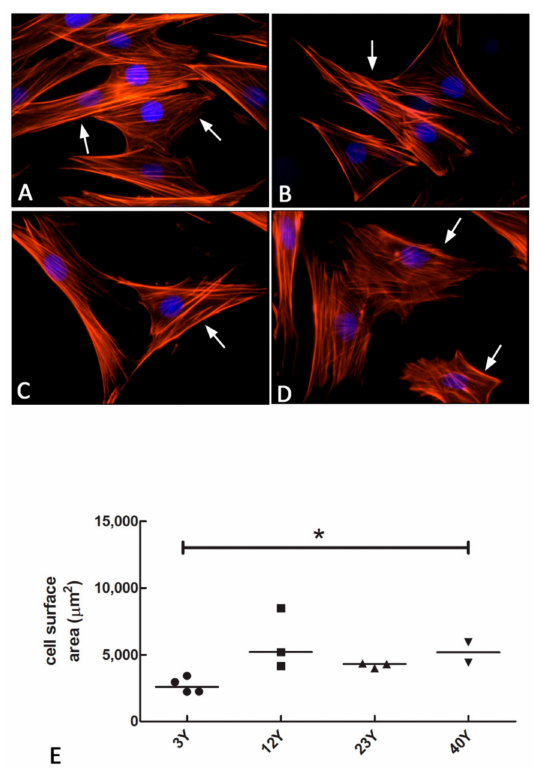
Figure 6. Fluorescence microscopy images of the phalloidin staining assay demonstrating the presence and distribution of actin fibers (red color; arrows) in equine SfMSCs isolated from donors of di ff erent ages. Nuclei were counterstained with DAPI (blue color). All the images have a magnification of 600 × and are representative of three independent experiments. ( A ) SfMSCs isolated from equine donors of 3 years of age; ( B ) SfMSCs isolated from equine donors of 12 years of age; ( C ) SfMSCs isolated from equine donors of 23 years of age; ( D ) SfMSCs isolated from equine donors of 40 years of age. ( E ) Quantitative analysis of the cell surface area of equine SfMSCs isolated from donors at di ff erent ages and stained with phalloidin probe. Values corresponding to each donor and the mean value (line) corresponding to each age-related group are represented. * represents a significant di ff erence between 3Y and 40Y groups; p <